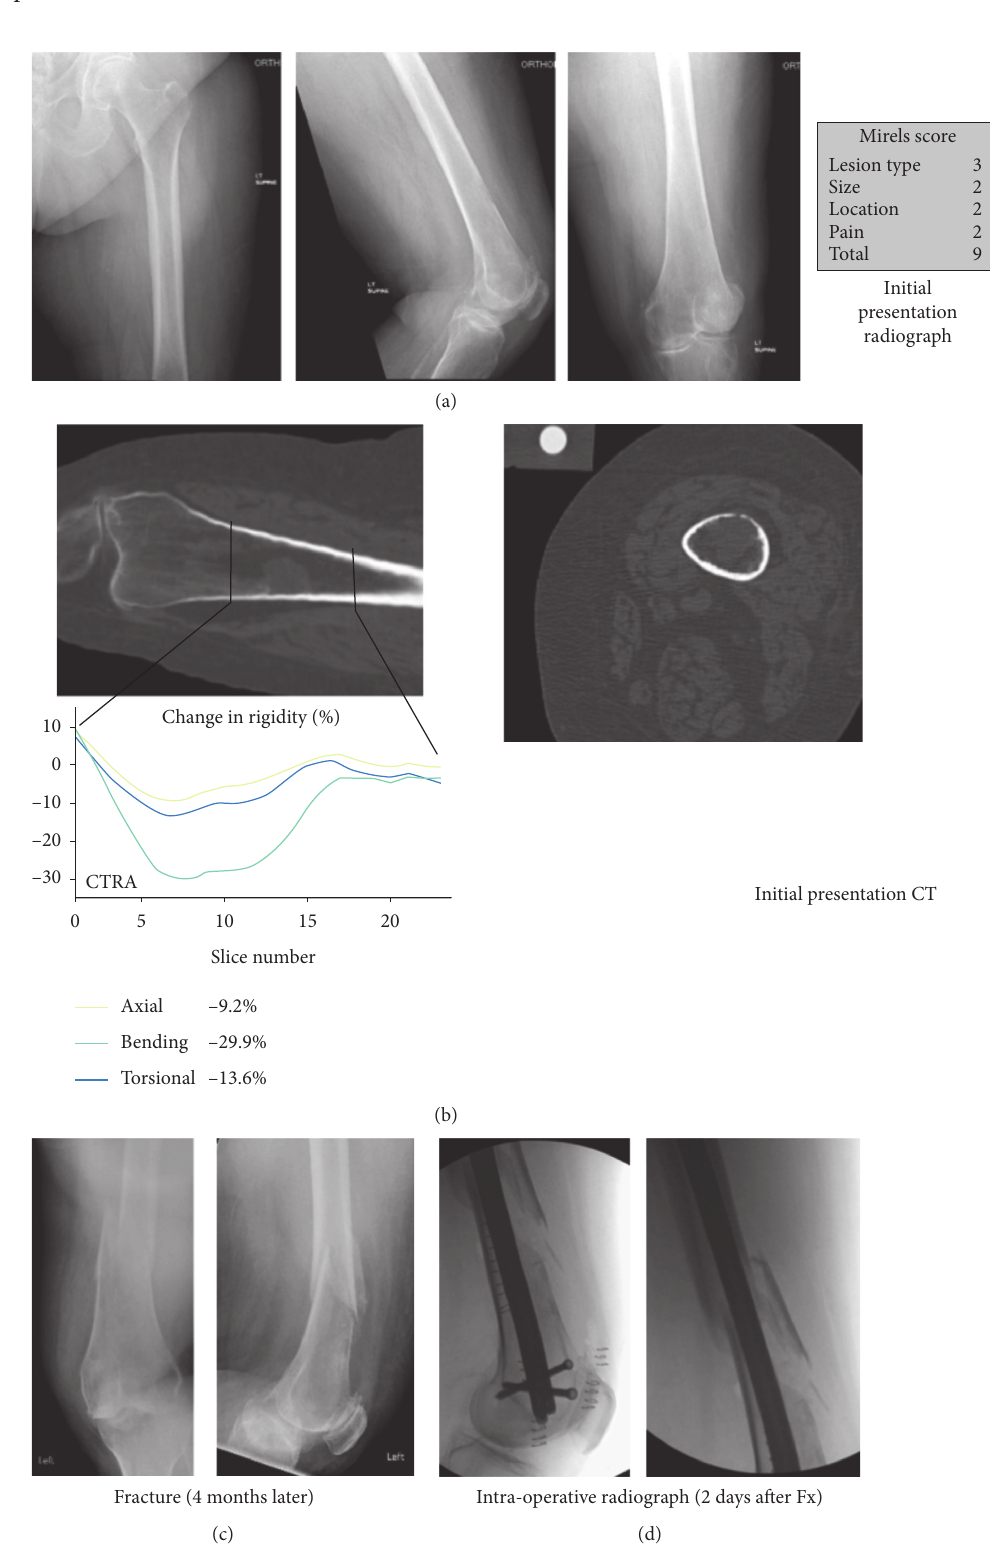
Figure 6: False negative (CTRA-/Fx+) (Case 5, L femur). (a) This is a 63-year-old male with metastatic renal cell carcinoma in the distal femoral diaphysis. (b) CTRA did not predict fracture in this patient, and FEA was not conducted due to the distal nature of this lesion. (c) The subject had a fall resulting in a fracture of the left femur and (d) underwent operative